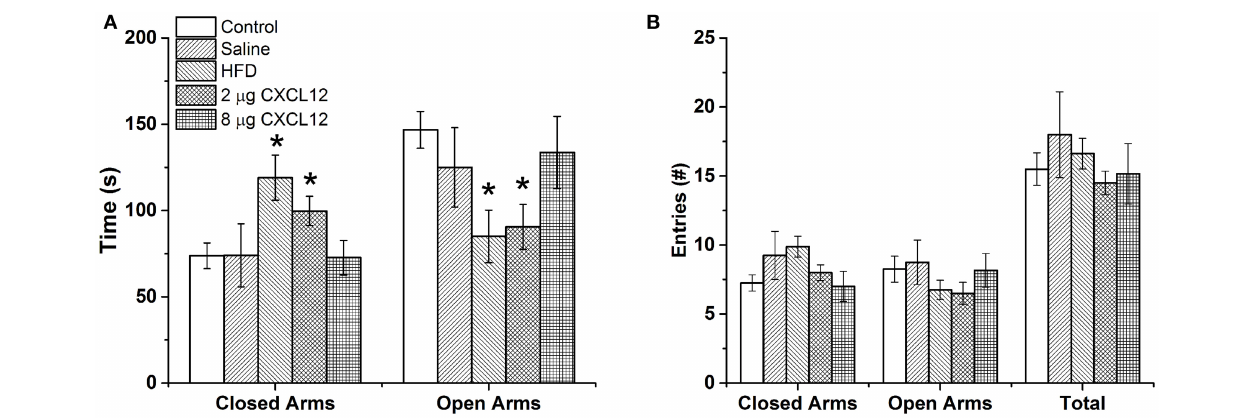
FIGURE 8 | Prenatal HFD and CXCL12 similarly increase anxiety-like behavior. (A) In an elevated plus maze, prenatal exposure to a HFD or CXCL12 at 2 µ g, but not 8 µ g, caused a significant decrease in time spent in the open arms and increase in time spent in the closed arms as compared to control offspring. (B) No differences in locomotor activity were found as measured by the number of entries into the open arms, closed arms, or total. * p < 0.05 vs.